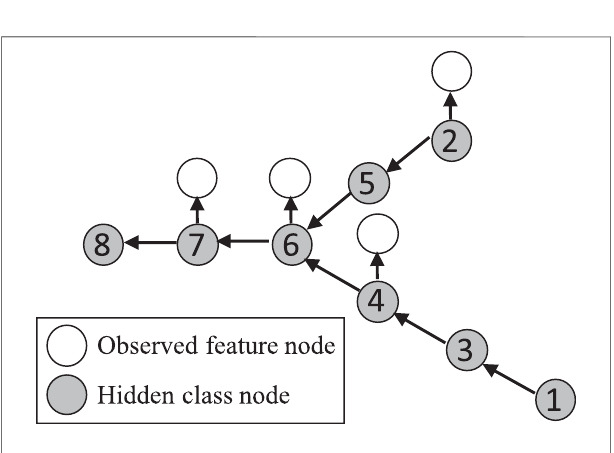
FIGURE 3 | Illustration of model structure.